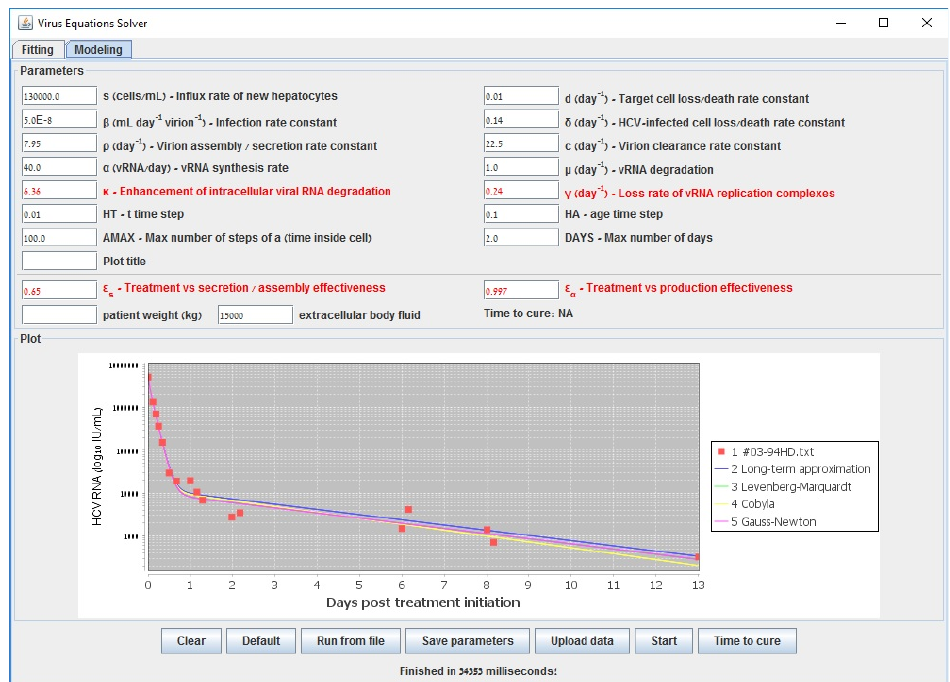
Figure 5. Comparison between the line fits of different methods inside the simulator window for the retrieved data points of patient HD that was reported in